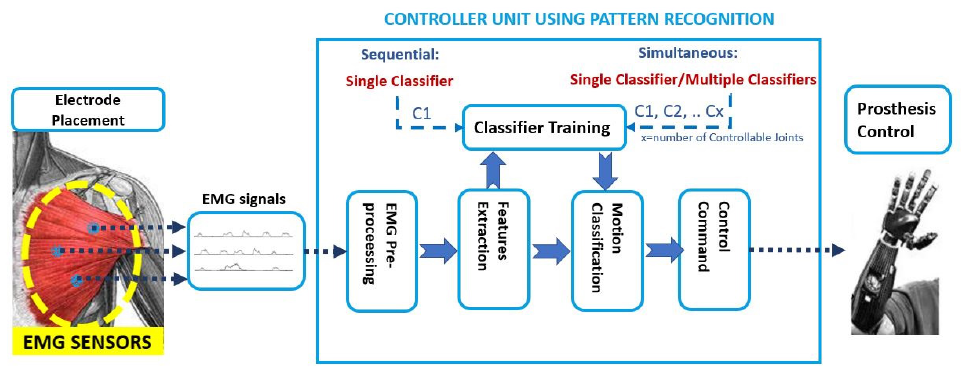
Figure 8. Pattern Recognition approach: the EMG signals are the input to the controller unit. Firstly the pre-processing step is done; then, in the features extraction step, the time and frequency domain features are used as input to train a single classifier or multiple classifiers. The classification output is the motion class to send as the command control to the